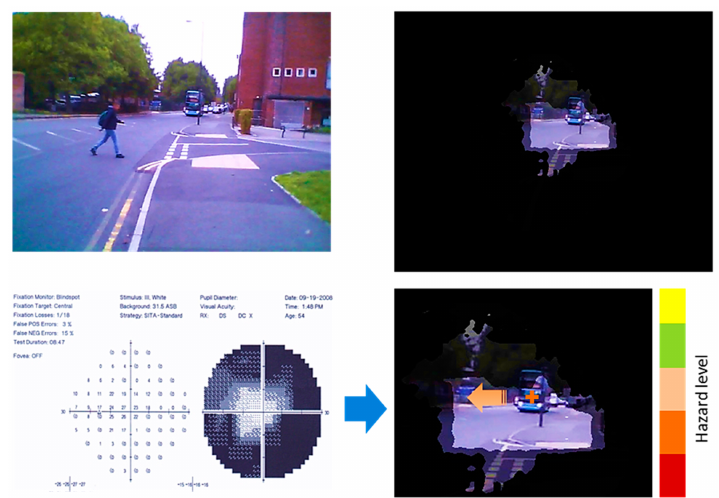
Figure 10. Feedback generation based on the visual field test. ( top left ) input video frame; ( bottom left ) visual field test result; ( top right ) the frame as viewed by a tunnel vision patient; ( bottom right ) sample visual notifications shown on the healthy vision